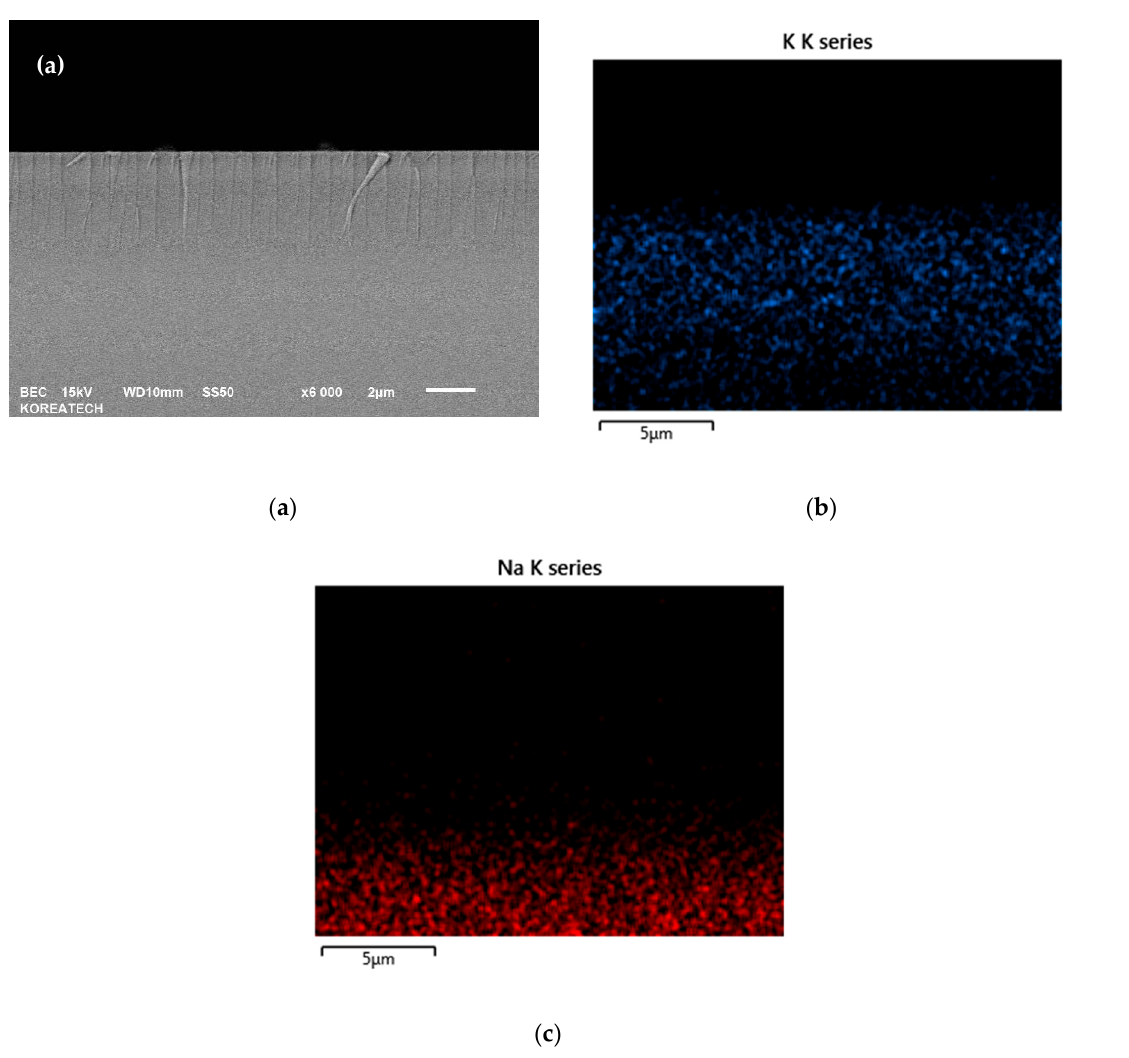
Figure 8. Cross-sectional SEM ( a ) and distribution of K + ( b ) and Na + ( c ) ions images of the glass heat treated at 420 °C for 3 h.